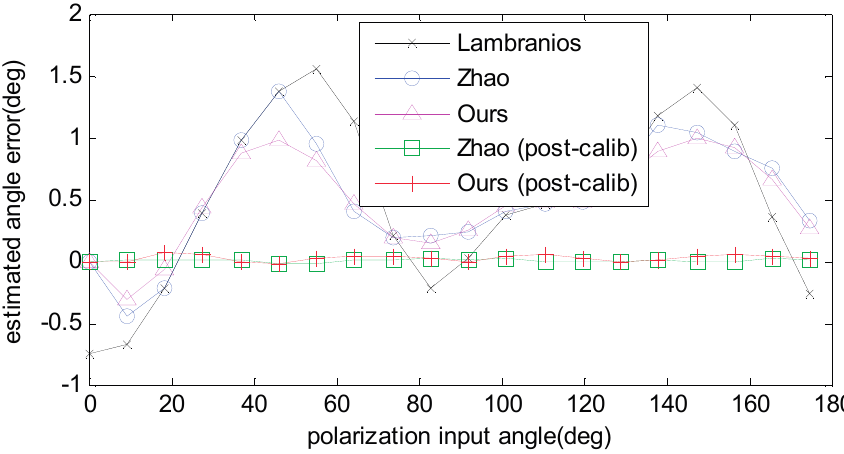
Figure 11. Angle computation results with real data. Three angle computation algorithms,